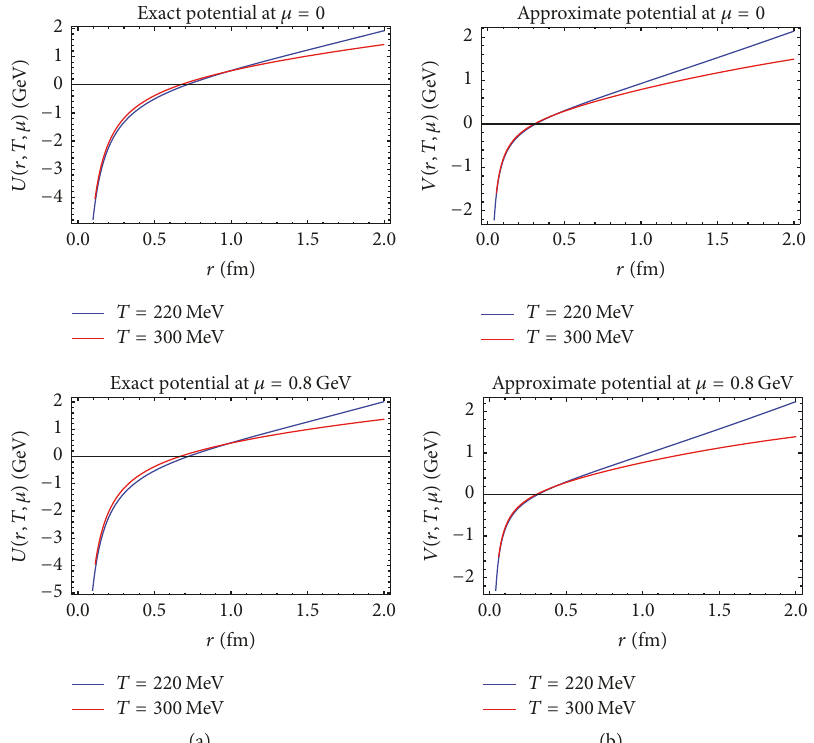
Figure 2: Two potentials are functions of distance ( r ), for different temperature and chemical potential. The exact potential 𝑈(𝑟, 𝑇,𝜇) in (a) and the approximate potential 𝑉(𝑟, 𝑇, 𝜇) in (b).